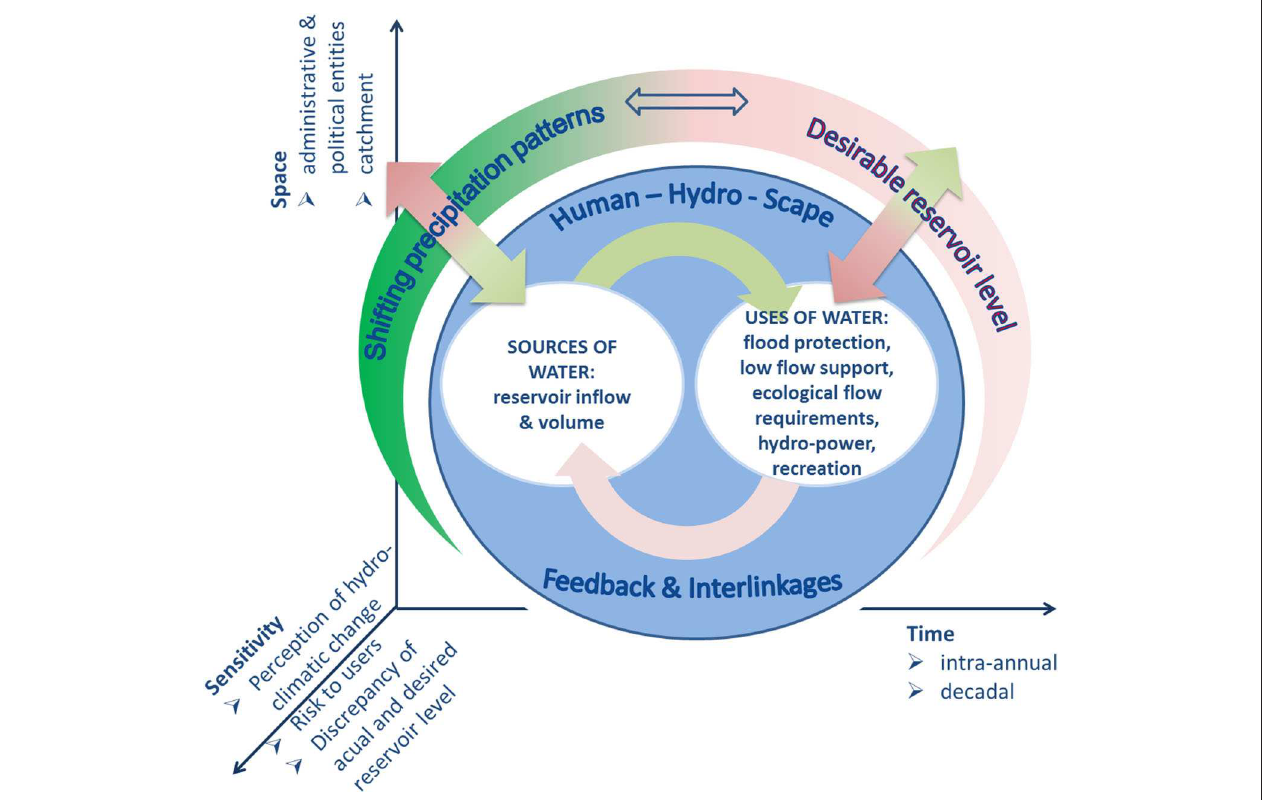
FIGURE 1 | Reservoir case study analyzed with PWR approach. Simplified representation. The human-hydro-scape opens the field of tension between water sources (physical) and water users (societal) with different priorities due to time or stakeholder preferences. Physical and human boundary conditions influence the human-hydro-scape in a reciprocal way where space, time, and sensitivity matters [based on the PWR approach of and modified after Evers et al.